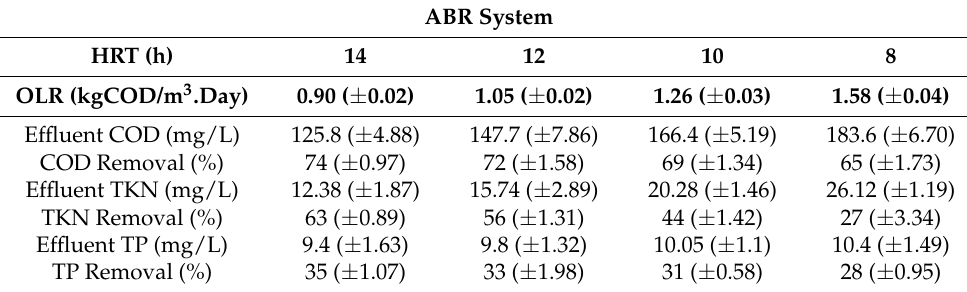
Table 3. Performance of ABR system during Phase